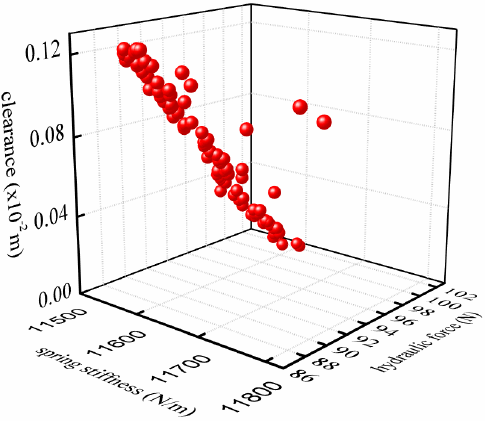
Figure 12. Pareto optimal solutions of spring stiffness, hydraulic pressure and backflow clearance.